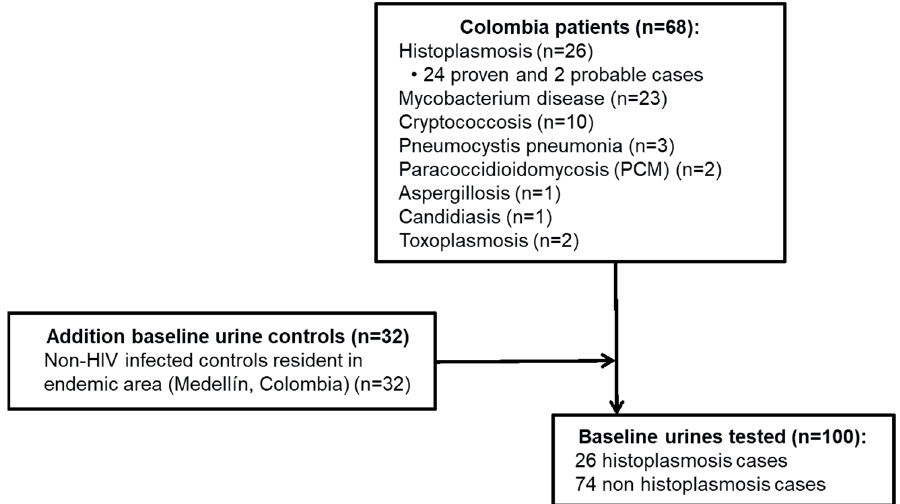
Figure 1. Study subjects and urine specimens analyzed during the validation of the commercial MVD Histoplasma Urine Ag lateral flow assay.